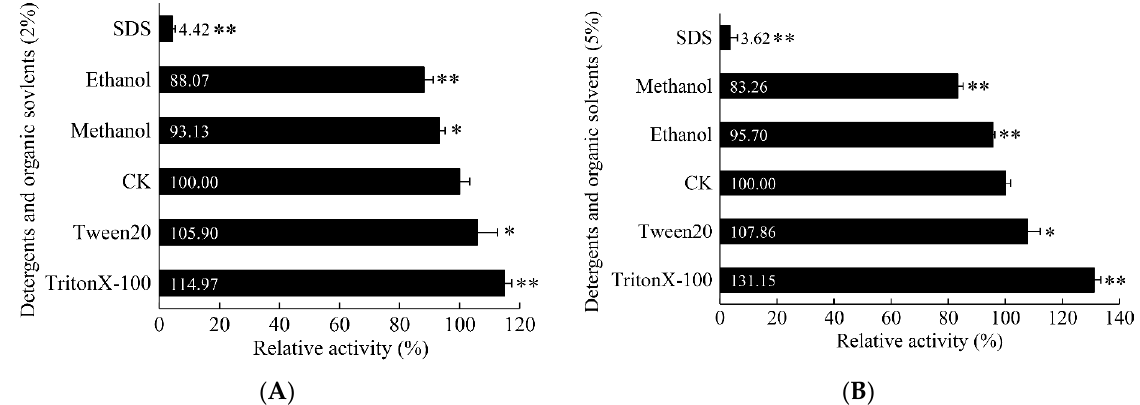
Figure 14. Influence of some detergents and organic solvents on BvAmylase activity. ( A ): 2% (w/v). ( B ): 5% (w/v). Condi- tions: 1% starch, pH6.0, 70 °C, 20 min. The purified BvAmylase activity was determined by preincubating the enzyme with detergents (SDS, Triton X-100, and Tween 20) and organic solvents (methanol and ethanol) at room temperature for 30 min at 2% (w/v) and 5% (w/v). The activity of the control without detergents and organic solvents was taken as 100%. All assays were performed four times at 70 °C, pH 6.0, and 20 min. Single and double asterisks denoted the experimental groups were statistically different from the control experiment 0.01 < p < 0.05 and p < 0.01, respectively.